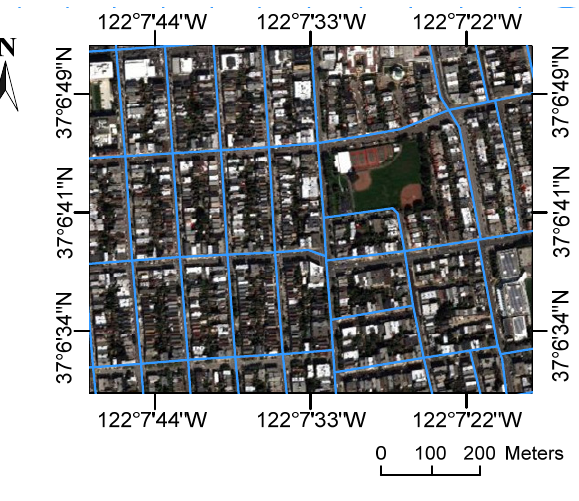
Figure 2. Image-to-vector geo-referencing of WorldView-2 imagery. This is one part of the Richmond District. The blue lines represent the road